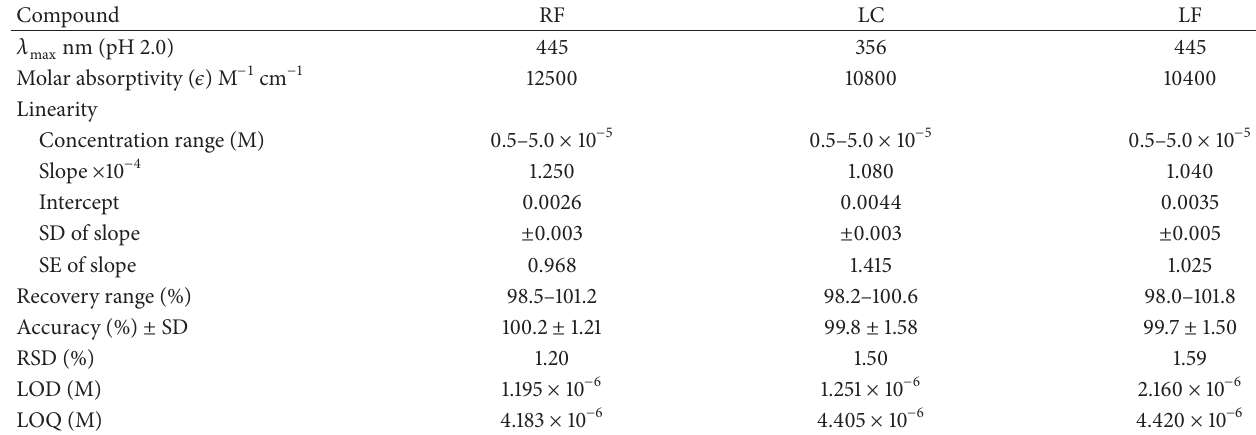
Table 1: Validation data for multicomponent spectrometric assay of RF, LC, and LF a .